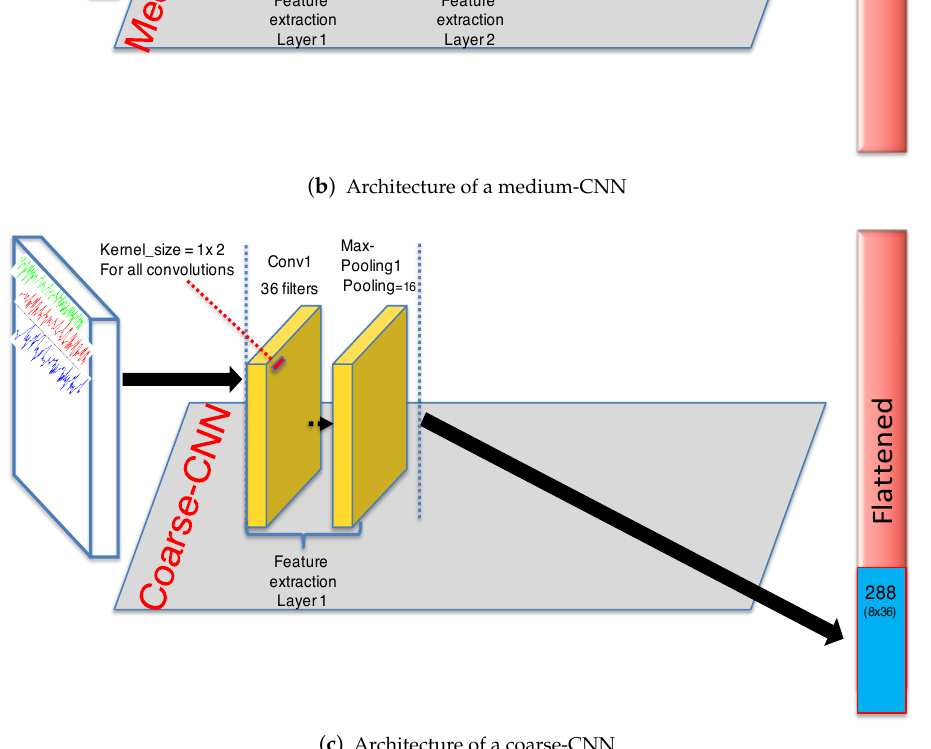
Figure 2. Partial CNN proposed